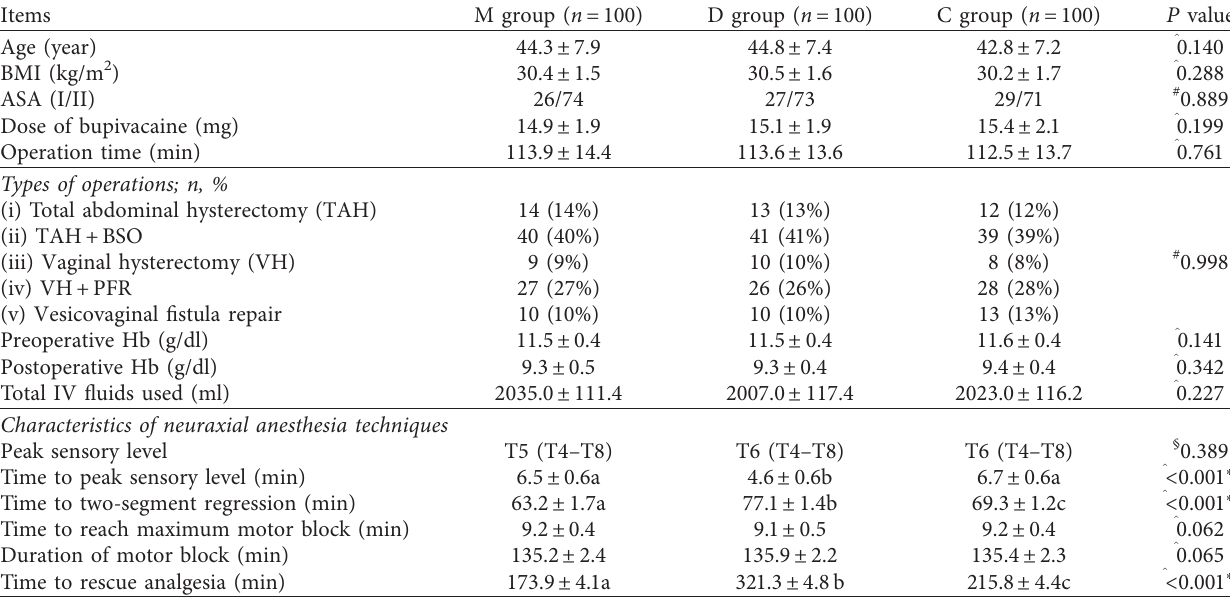
Table 1: Patients’ demographics and perioperative data.